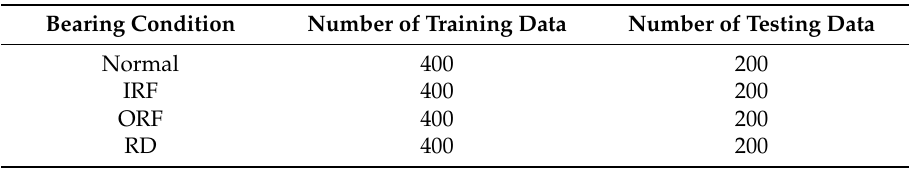
Table 1. Description of the bearing data set.